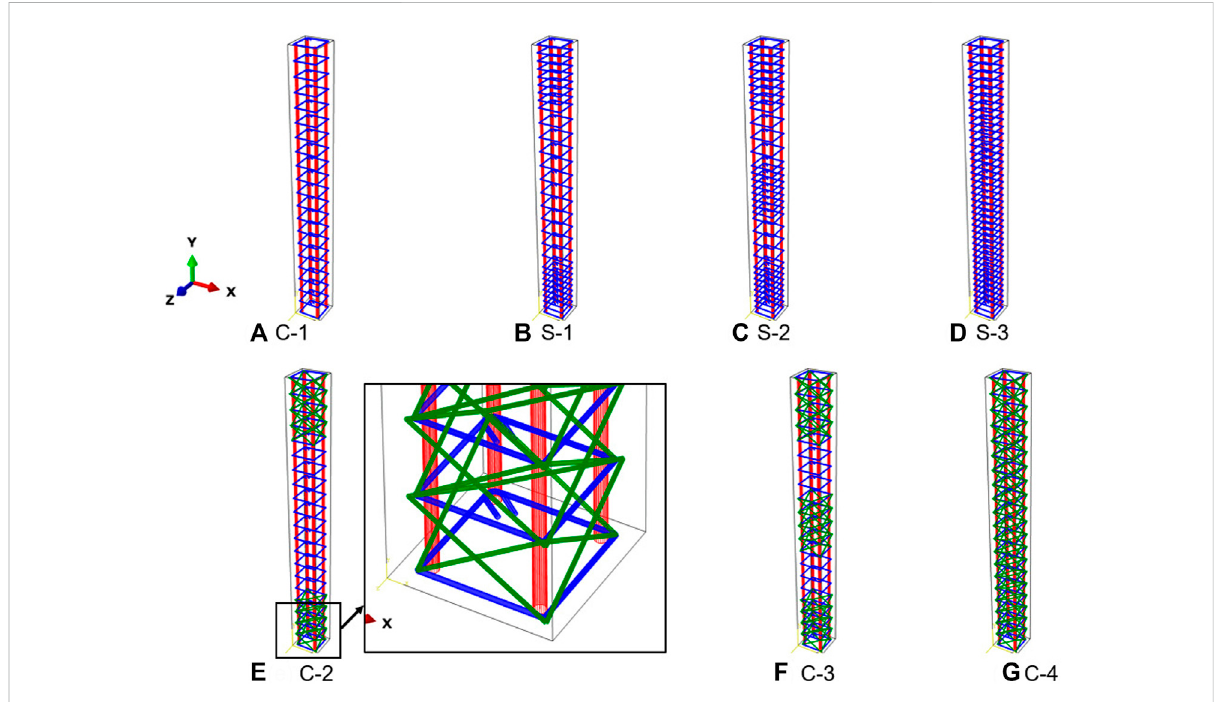
FIGURE 2 Three-dimensional view of the reinforcements of the columns.